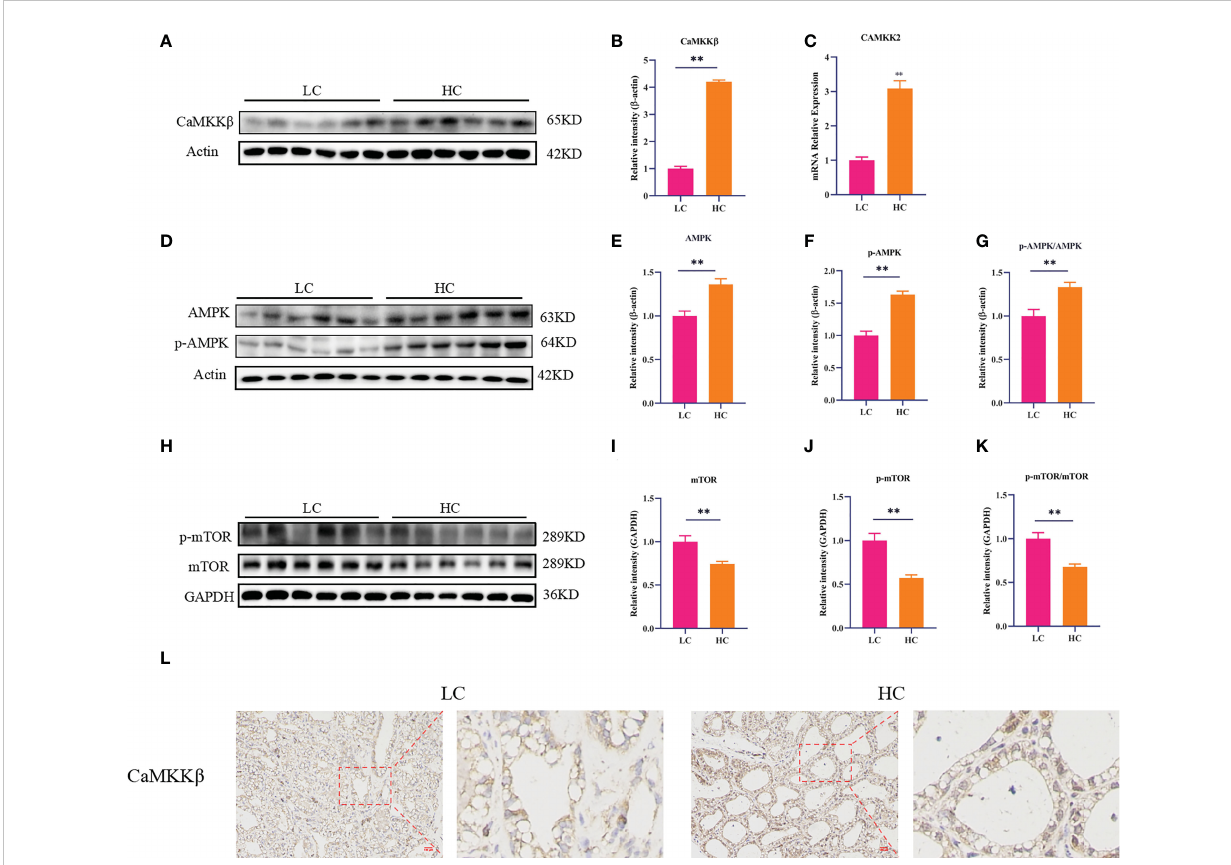
FIGURE 3 CaMKK b /AMPK/mTOR signaling pathway in mammary gland tissue of dairy cows. The mRNA abundance of CaMKK2 (C) . Protein levels of CaMKK b , AMPK, p-AMPK, mTOR, p-mTOR, and p62 (A, B, H) . Protein expression was normalized to the respective abundance of b -actin and GAPDH (C – G, I – K) . Sections of dairy cows ’ mammary gland tissue immunostained for CaMKK b in the LC diet and HC diet (200× magni fi cation, (L) . Red bar, 100 m m. All results are expressed as the mean ± SEM. ** p <